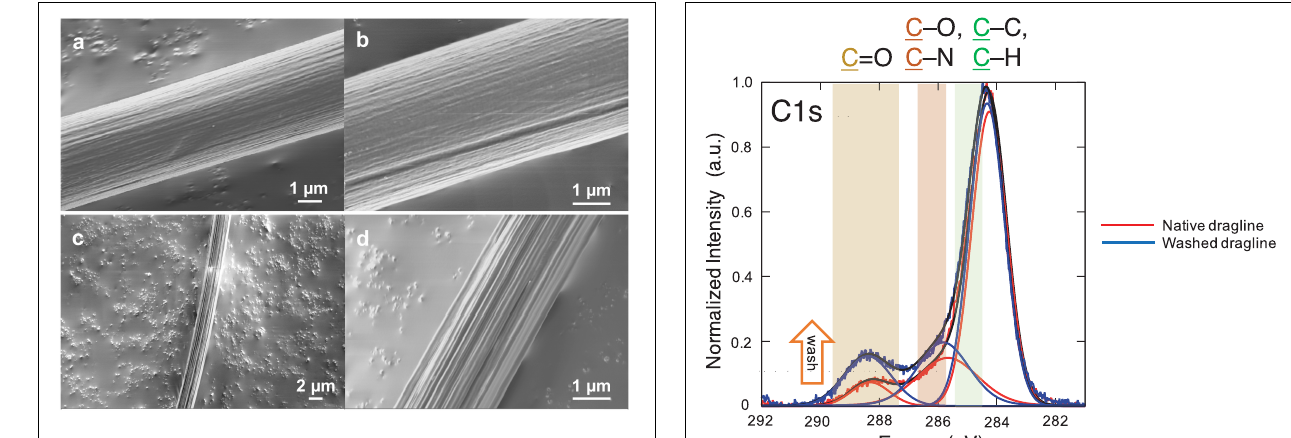
FIGURE 2 | FE-SEM images showing the surface of Nephila spider dragline after proteinase-K treatment. (b,d) Are enlarged images of (a,c) , respectively. fitting protocol used the Gaussian-Lorentzian function, but the best fit results were obtained with Gaussian 100%.